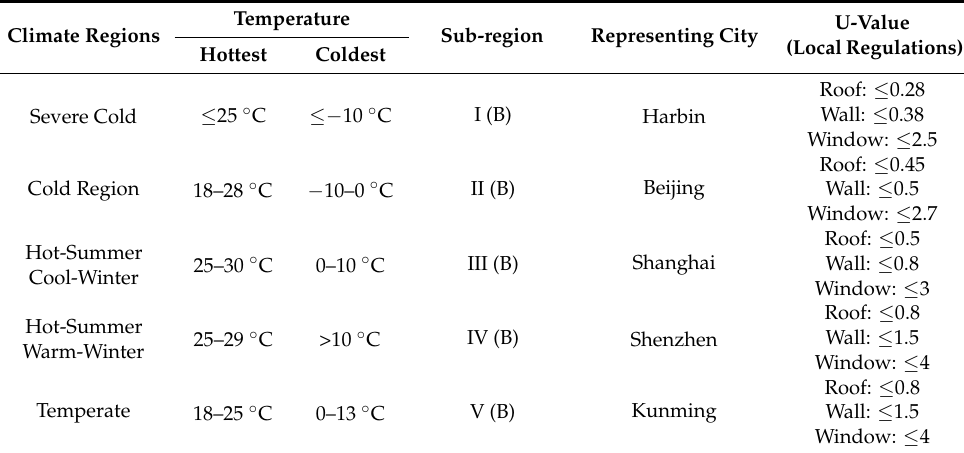
Table 1. Five studied cities by climate zones.